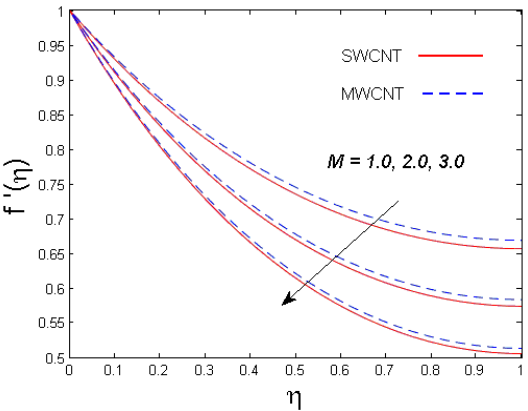
Figure 6. The illustration of M versus f ’(η).